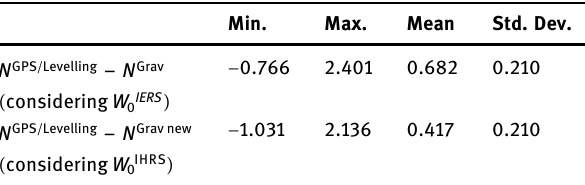
Table 6: Statistics of the di ff erences between undulations N Grav new with GPS/levelling - derived geoid in meters Min. Max. Std. Dev.